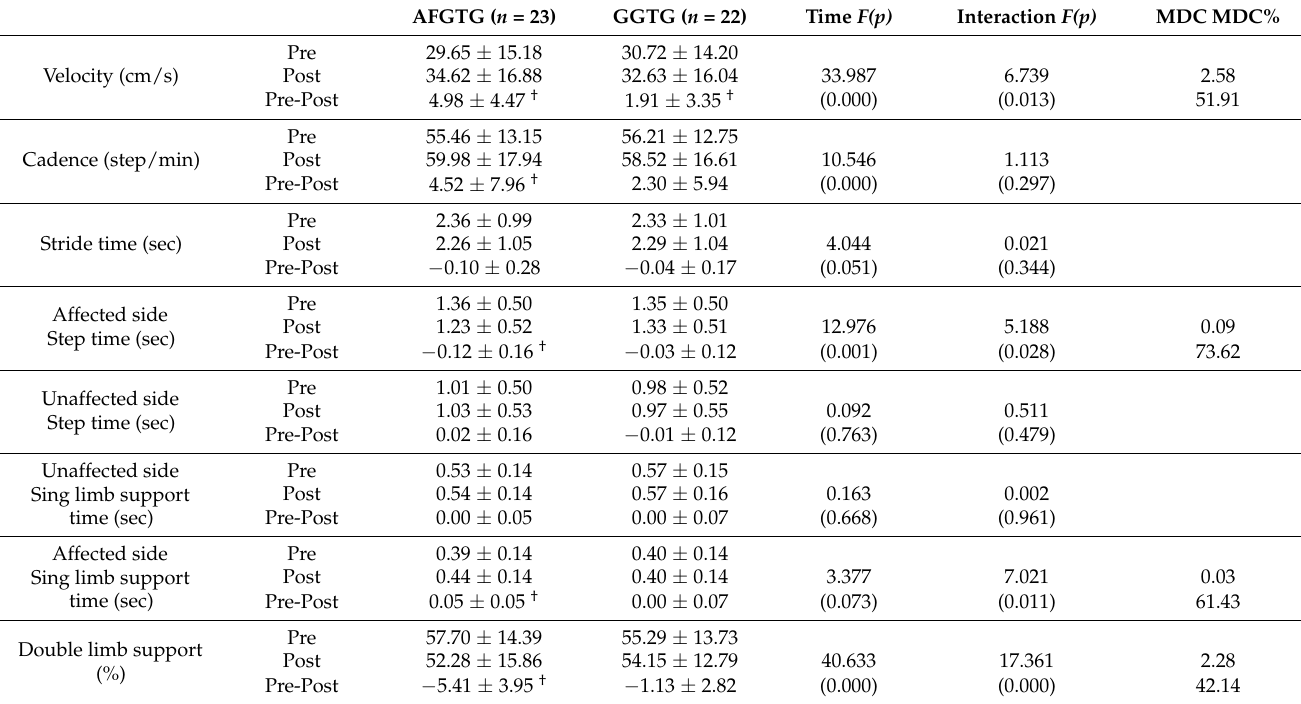
Table 2. Changes of temporal gait parameter.